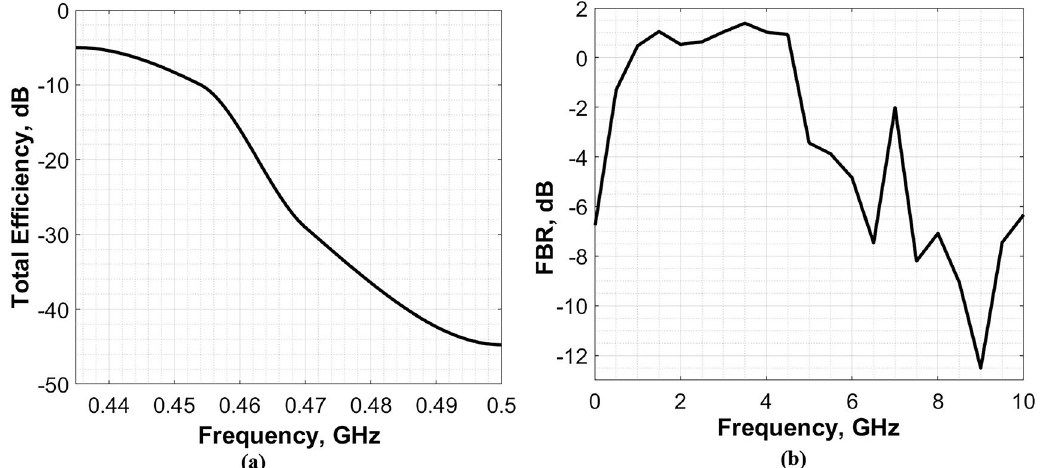
Figure 12. The simulated ( a ) total efficiency, and ( b ) front to back ratio of the proposed